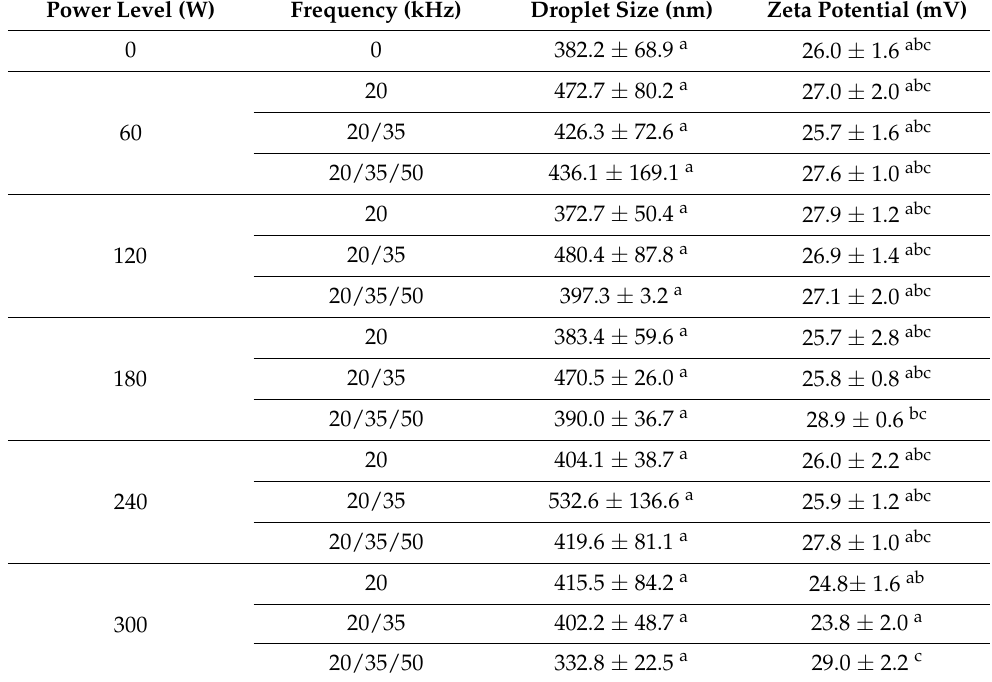
Table 2. Droplet size and zeta potential of the emulsions prepared with whey protein modified by ultrasound at different frequency and power (n =